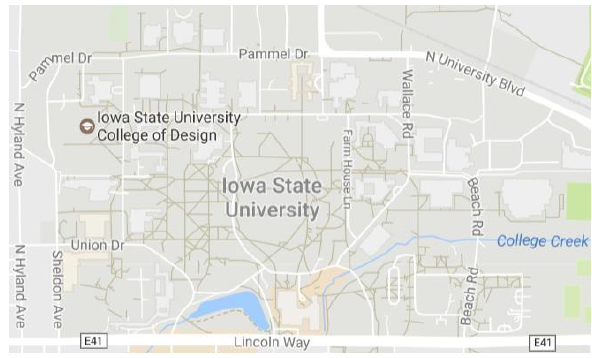
Figure 3. ISU campus area, Ames, Iowa